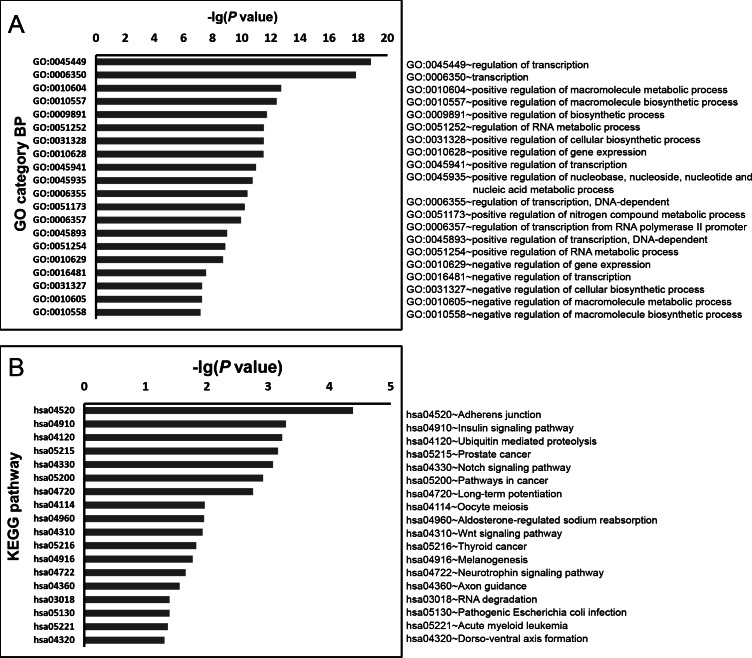
GO biology process and KEGG pathway enrichment analysis for predicted miRNA targets of miR-3613-3p.GO biology process and KEGG pathway enrichments were performed by mapping the predicted target genes using DAVID online analysis tool. P < 0.05 was used as a threshold to select significant GO terms and KEGG pathways. −lg(P value) is the negative log10 of the P value. The top 20 GO biology processes accordign to −lg(P value) and a total of 18 KEGG pathways for miR-3613-3p were annotated. GO, Gene Ontology; BP, biology process; KEGG, Kyoto Encyclopedia of Genes and Genomes.